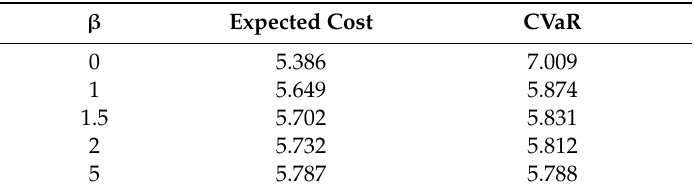
Table 7. Expect cost and conditional value-at-risk (CVaR) trade-o ff for di ff erent risk postures (million €